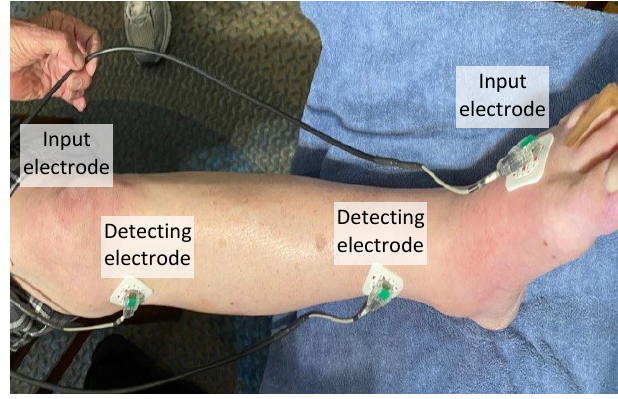
Figure 3. EIS electrode placement on the calf. Informed